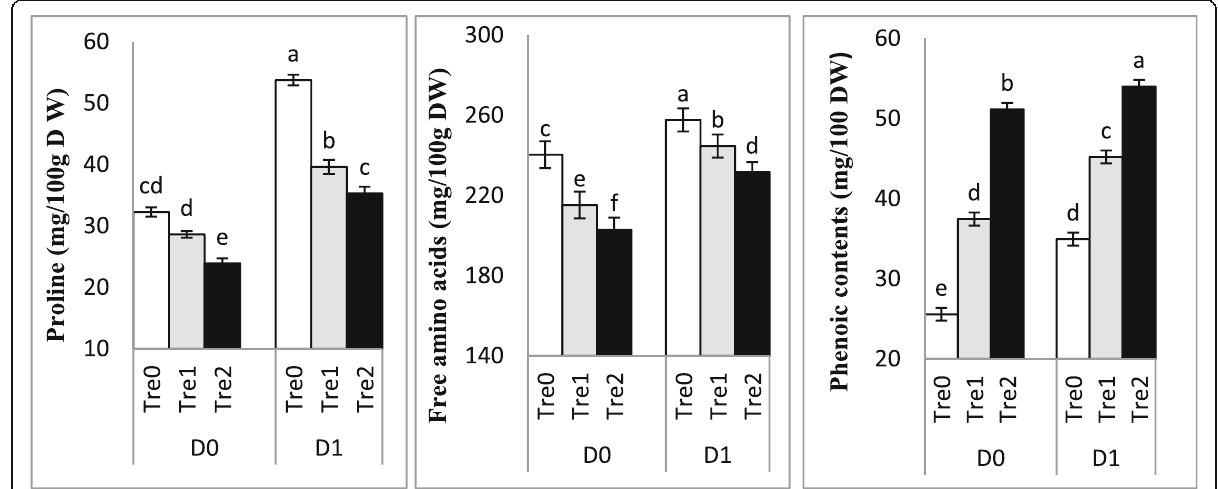
Fig. 2 Effect of trehalose (Tre1, 0.1 mM and Tre2, 0.5 mM) on proline, free amino acids and phenolic contents (mg/100 g DW) of quinoa plant under drought stress (at 75 days from sowing). Each value represents the mean ± standard error ( n = 4). Means with different letters above bars were significantly different at the 0.05 level according to Duncan ’ s multiple range test